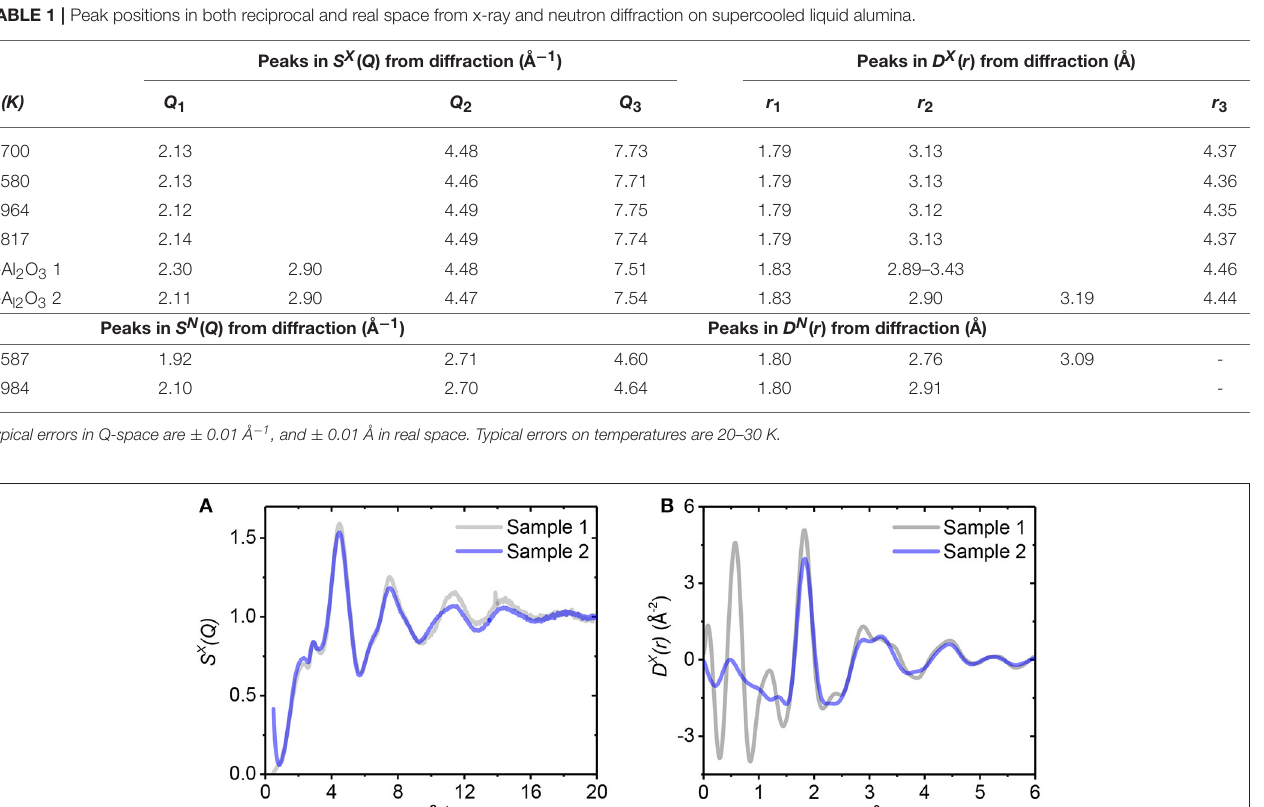
Frontiers in Materials |